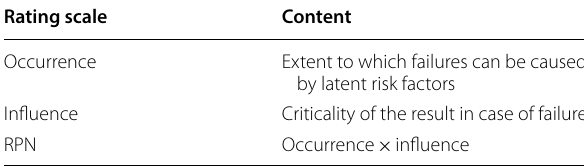
Table 1 FMEA evaluation items for this